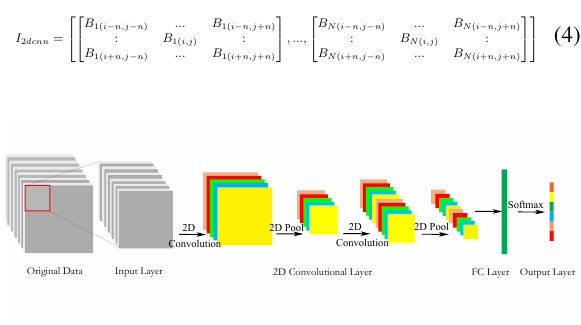
Figure 2. The architecture of 2D-CNN